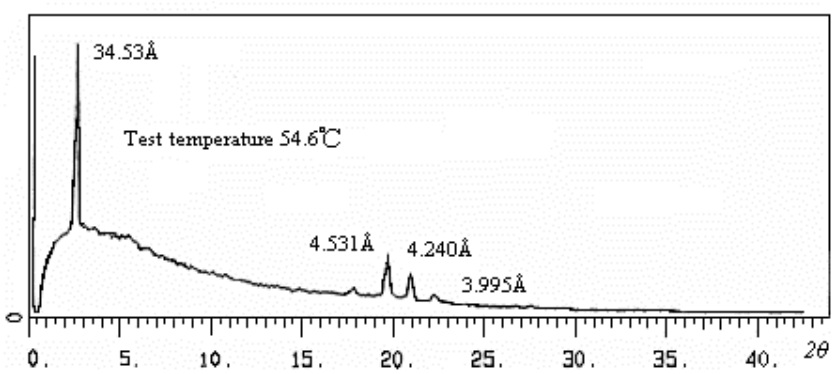
Figure 2. X-ray di ff raction trace of 9M . Figure 2. X-ray diffraction trace of 9M .